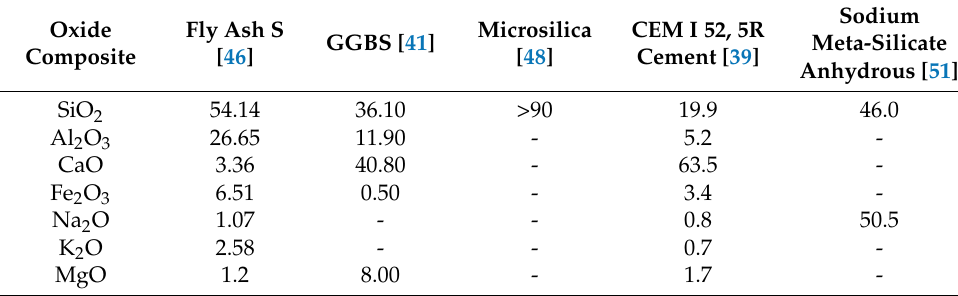
Table 1. Properties of binders and